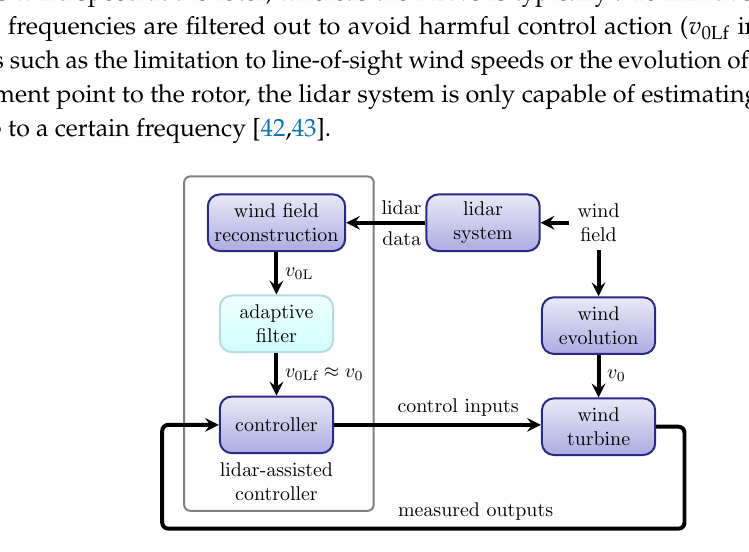
Figure 3. Basic control loop of lidar-assisted wind turbine control, based on